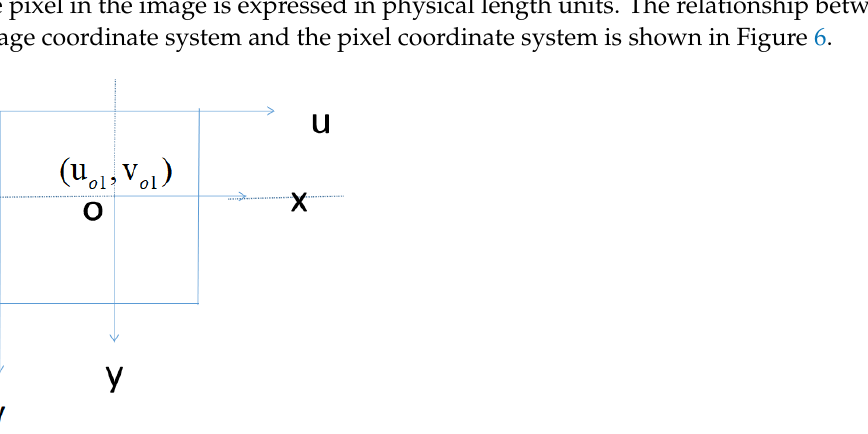
Figure 6. Relationship between image coordinate system and pixel coordinate system.